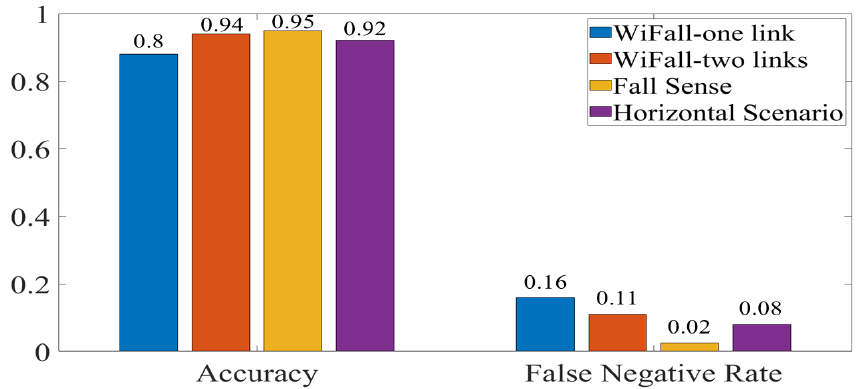
Figure 13. Comparison of Wifall, FallSense and HH